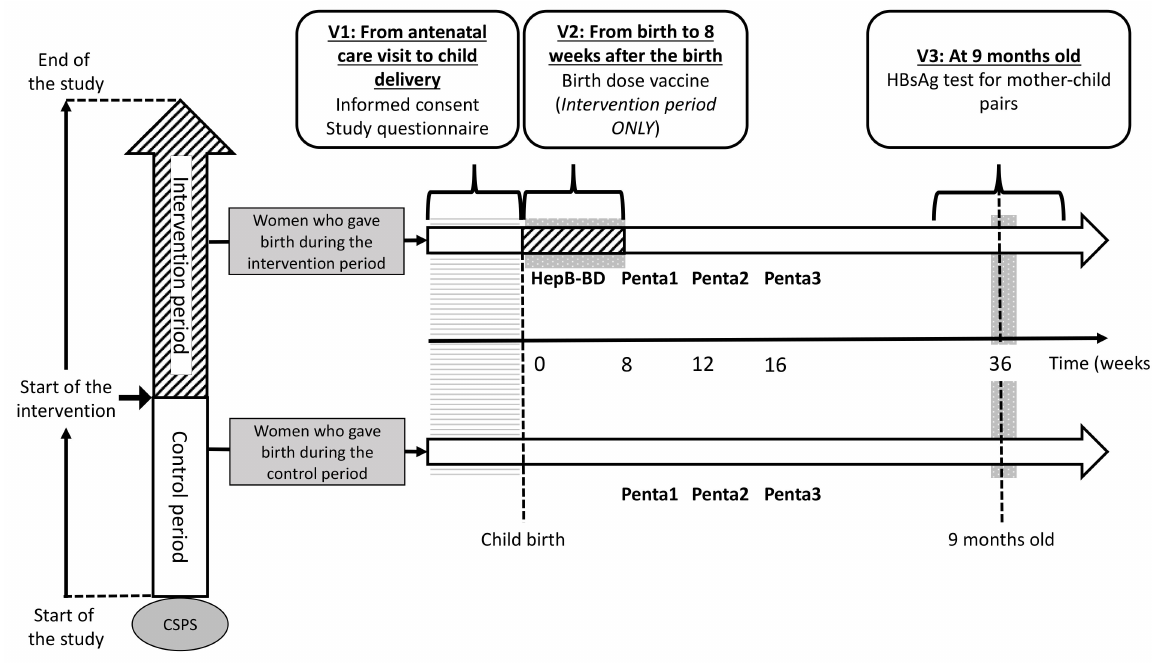
Figure 3. Participant